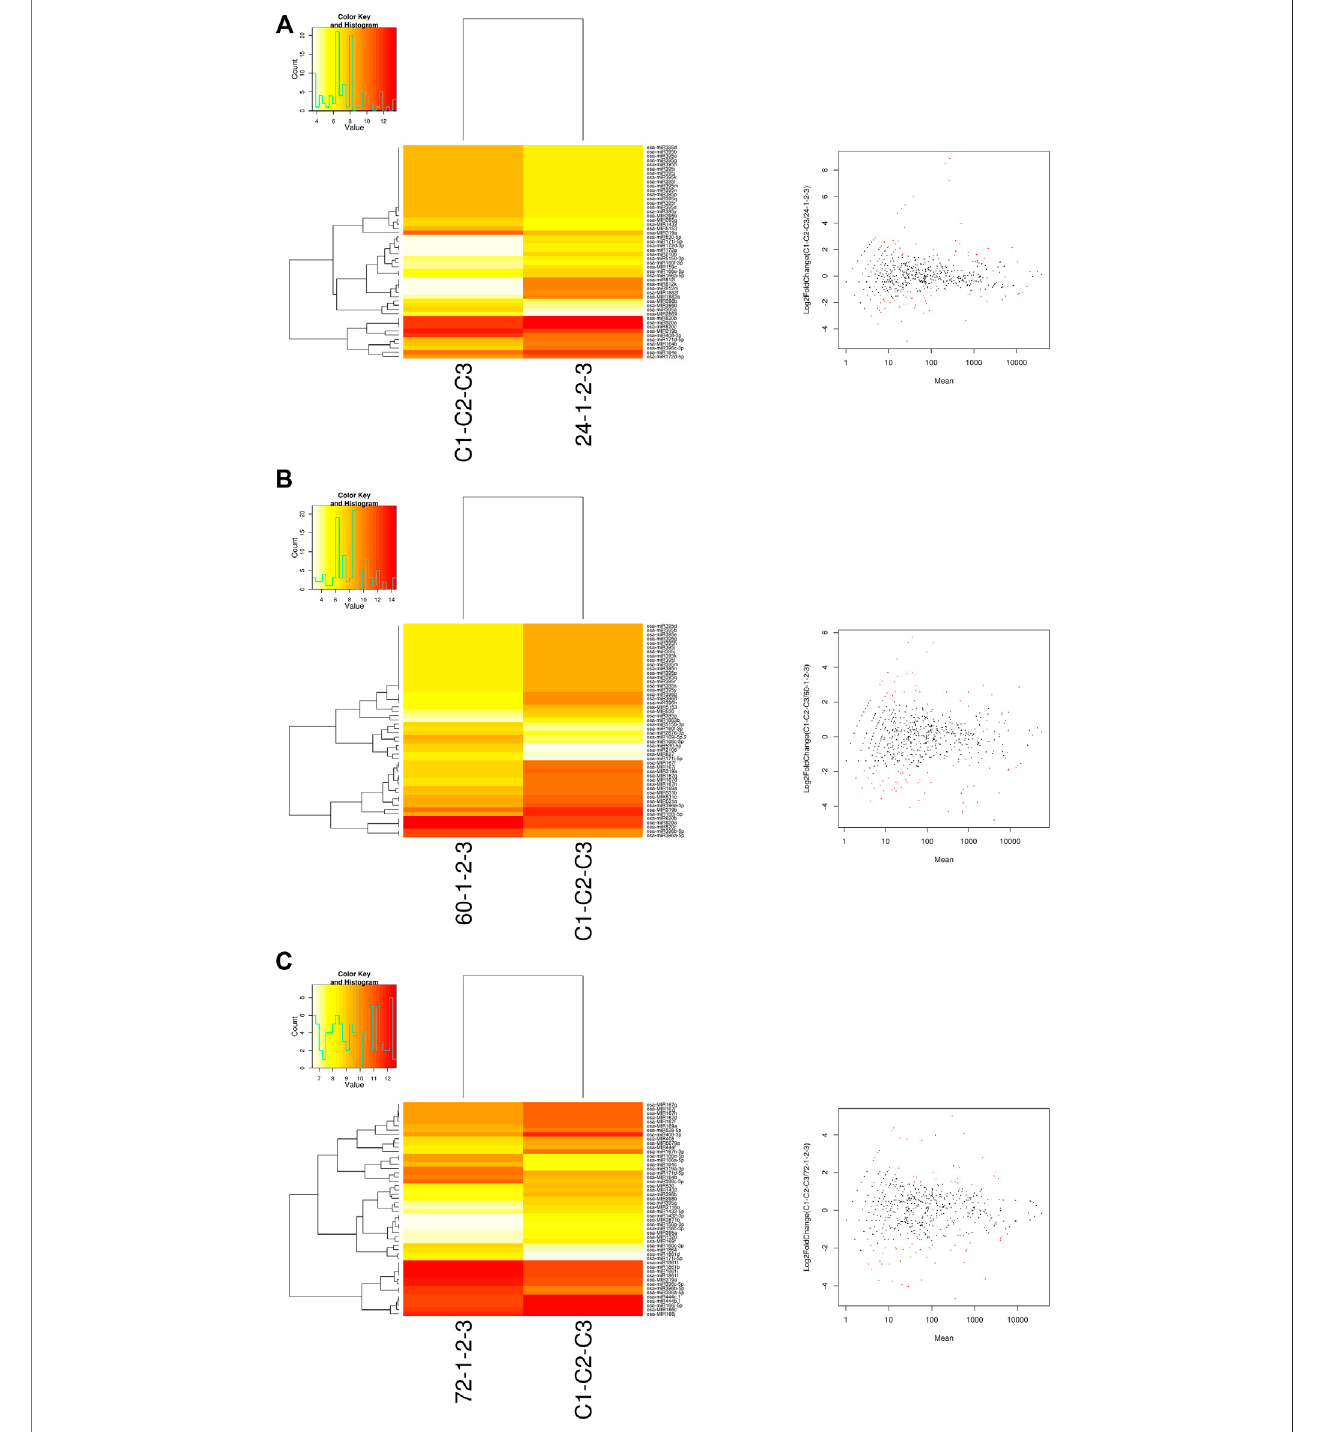
FIGURE3| HeatmapandMAplots.Theheatmapsweregeneratedforthecontrolsampleversusthesampleateachoftheinfectedtimepointssuchas (A) 24 hpi, (B) 60 hpi, and (C) 72 hpi with the normalized read count data matrix using a g-plot heat map. The plot shows the hierarchical clustering of both samples (yellow shows low-level expression; red shows high-level expression). The log 2 fold change expression values were calculated by DESeq in binomial mode. The MA plots were generated to identify the ≥ 2-fold (highly expressed) and ≤ -2-fold change (low expressed) miRNAs. X-axis represents the difference between the log 2 fold change values, and Y-axis represents the average of the log 2 fold change values. The red dots in MA-plots represent the potential miRNAs expressed upon R. solani infection.